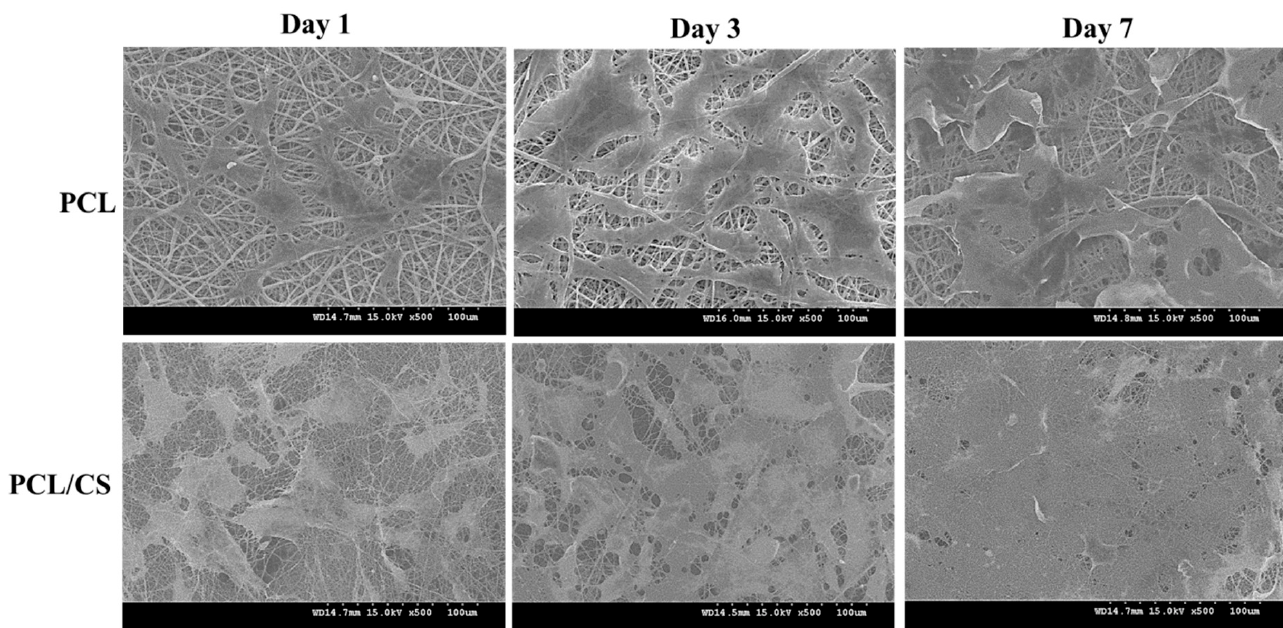
Figure 4. The scanning electron microcopy (SEM) images of cell-seeded PCL and PCL/CS nanofiber membranes after being cultured for 1, 3 and 7 days. Bar = 100 µm.